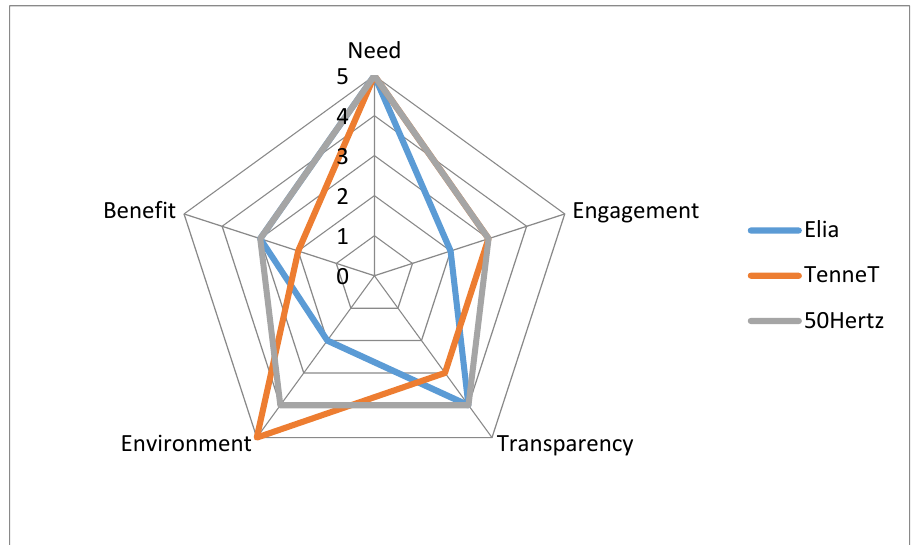
Figure 3. Concerns according to five guiding